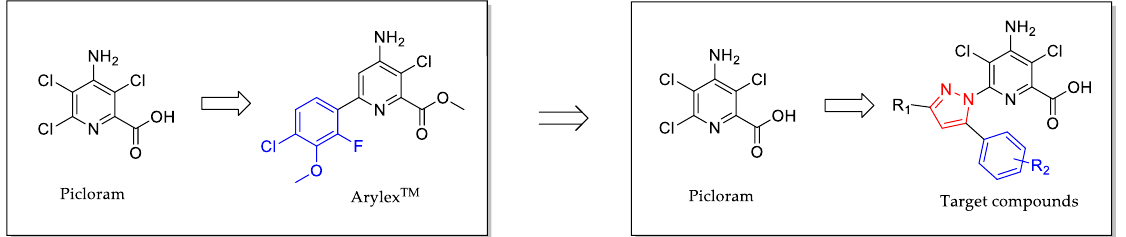
Figure 3. Design strategy of target compounds.